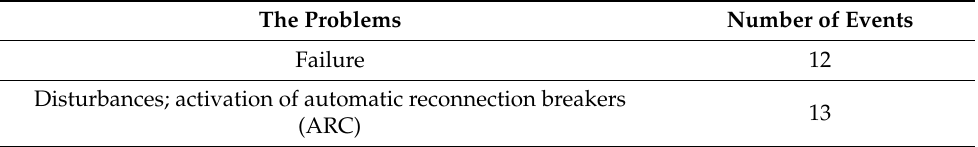
Figure 2. The system structure in the outage condition F-1 in a fail state of a 110 kV line. The 30 kV line section between EPS “B” and the ACRs runs in a difficult area; therefore, it is exposed to increased failure rate. The one-year data contained in Table 3 are obtained from the local DSO. Table 3. Events list in MV 30 kV lines between EPS “B” and automatic circuit reclosers (ACRs).